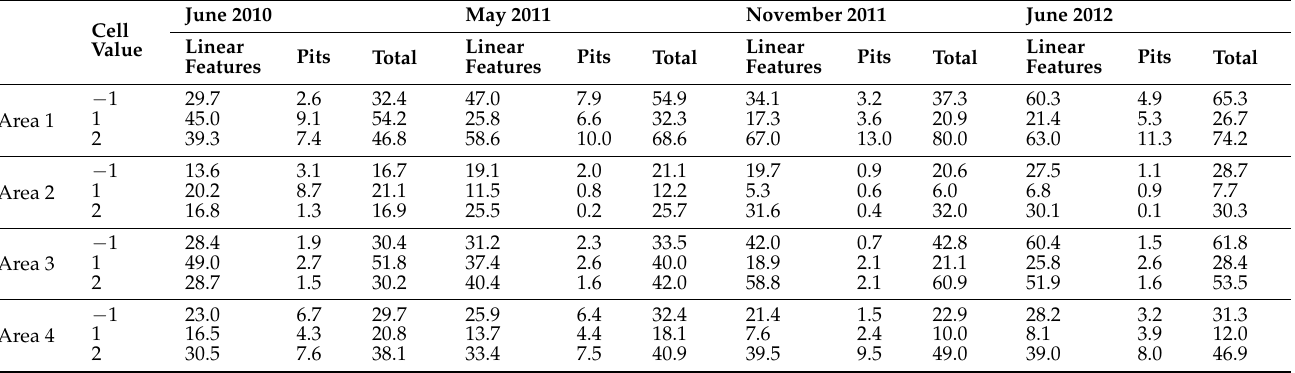
Table 3. Results of comparing the Spring 2007 data with the four other sets. The values comprise the sum of raster cells for (i) linear features, (ii) pits, and (iii) for these categories together. Numbers divided by